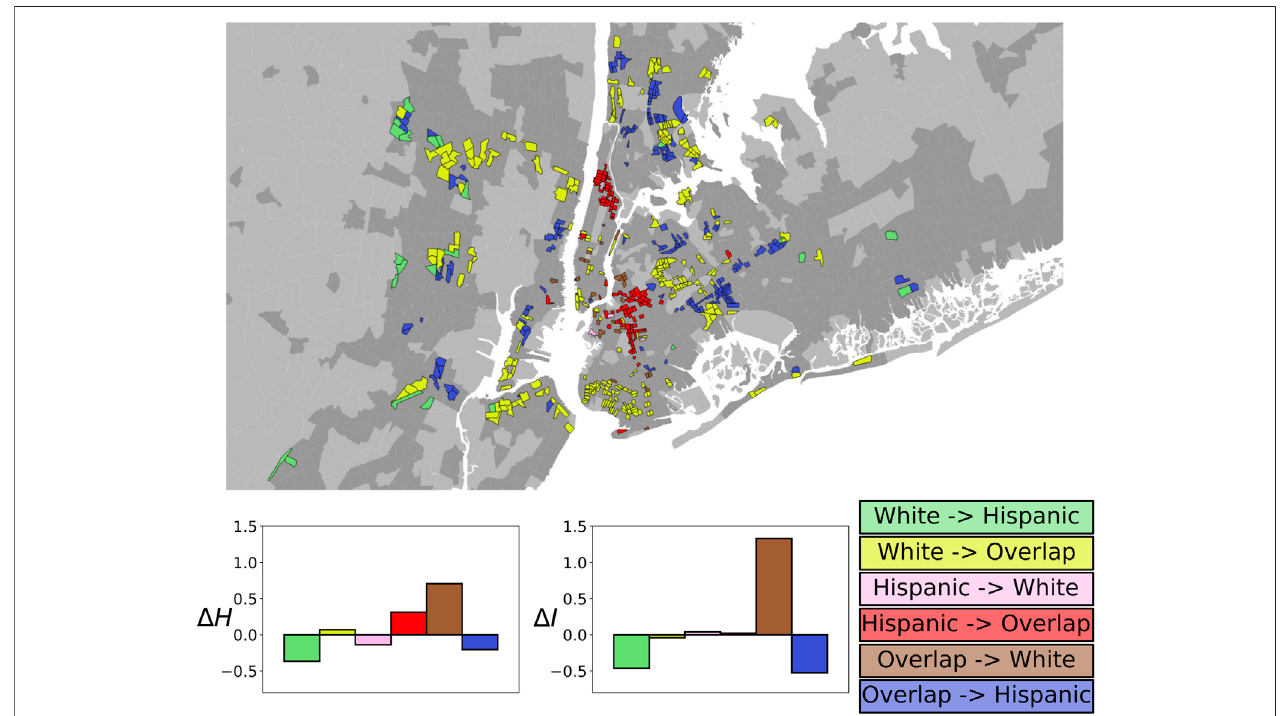
FIGURE 7 | Tracts that migrated from one zone to another or to the Overlap zone from 1990 to 2010: white and Hispanic citizens. Tracts that changed zone from 1990to2010areshownonthemap,whilethecolorsindicatethechangefromwhitetoHispanic(green),fromwhitetooverlap(yellow),fromHispanictowhite(pink),from Hispanic to overlap (red), from overlap to white (brown), and from overlap to Hispanic (blue). Furthermore, for each migration alternative, the values of Δ H and Δ I are shown at the bottom panels.